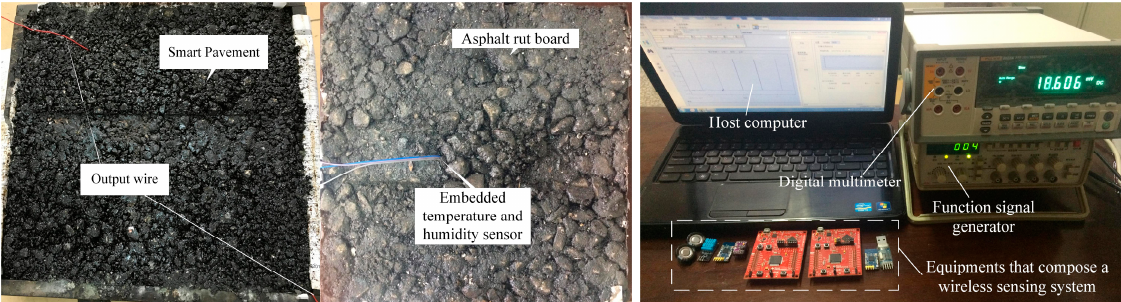
Figure 20. Lab setting for measurements.